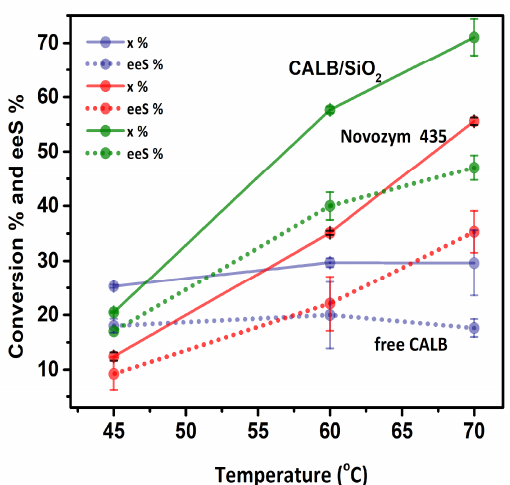
Figure 9. Conversion and enantiomeric excess toward S -ibuprofen of free CALB, Novozym ® 435 and CALB lipase immobilized on Ns SiO 2 (0.028 µmol.m −2 ) in the esterification of rac -ibuprofen with ethanol at 45 °C, 60 °C and 70 °C for 9 h.